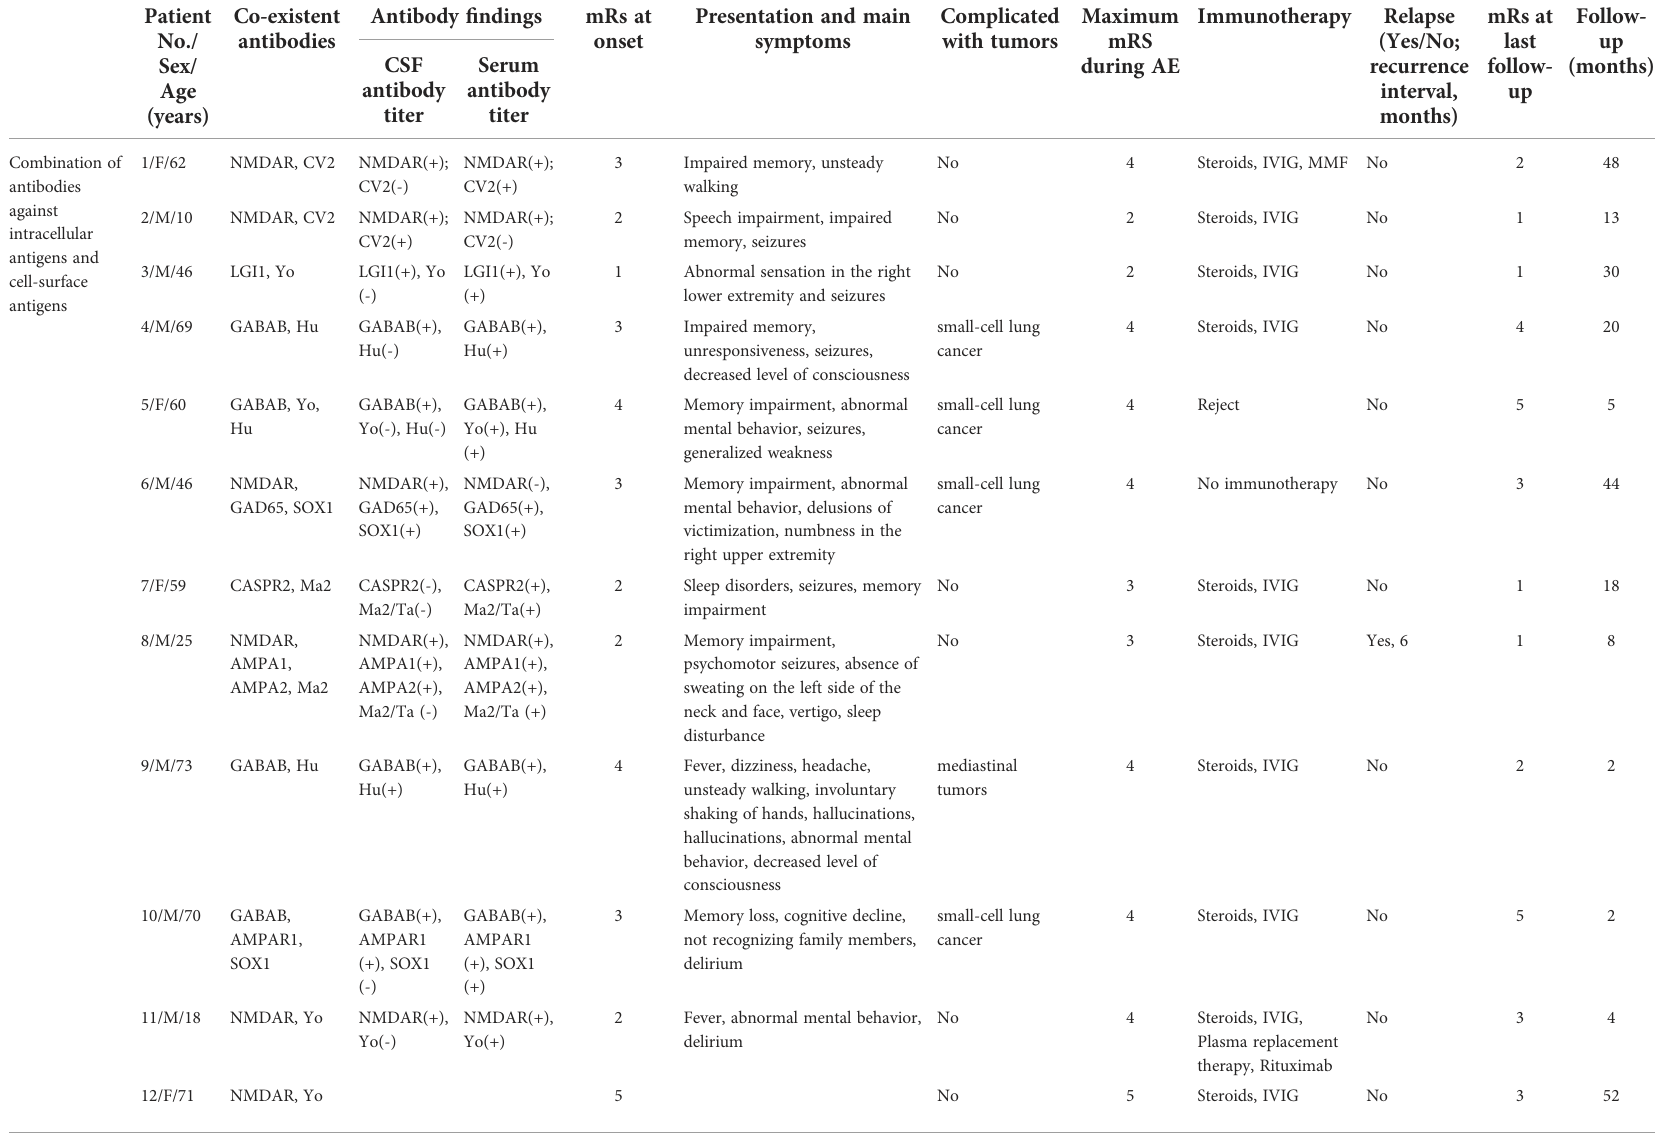
TABLE 1 Clinical characteristics of patients with co − existence of multiple anti − neuronal